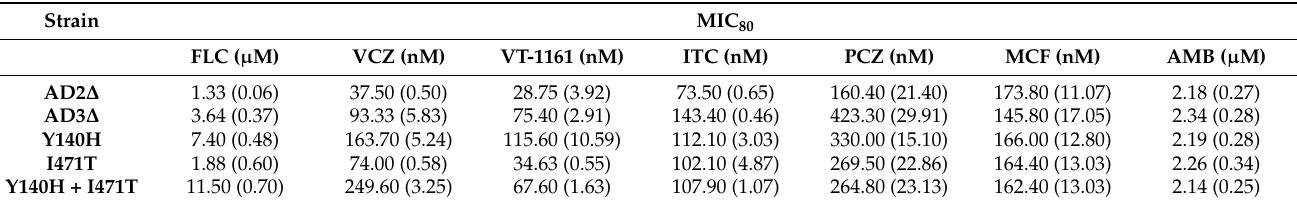
Table 1. Susceptibilities to azoles of test and control yeast